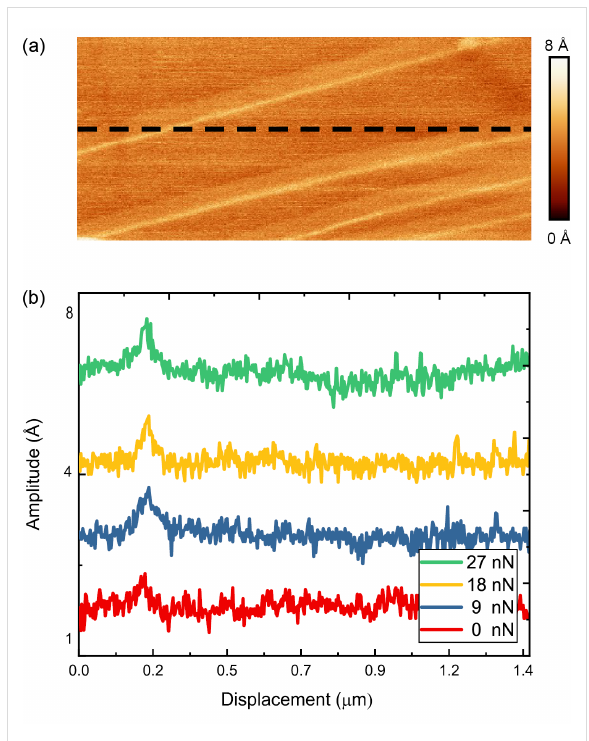
Figure 7: (a) Amplitude map obtained while the tip traversed four single-height, uncovered atomic steps on an HOPG surface in CR (modulation frequency = 78 kHz). (b) Amplitude line profiles acquired along the black dashed line in (a). The normal force was increased from 0 nN (red), 9 nN (blue), 18 nN (yellow), and 27 nN (green) while recording the amplitude variation. Each line profile has been offset by a value of 4 Ångström to make identification of the amplitude variation over the uncovered step clear. The data presented in this figure were acquired with tip